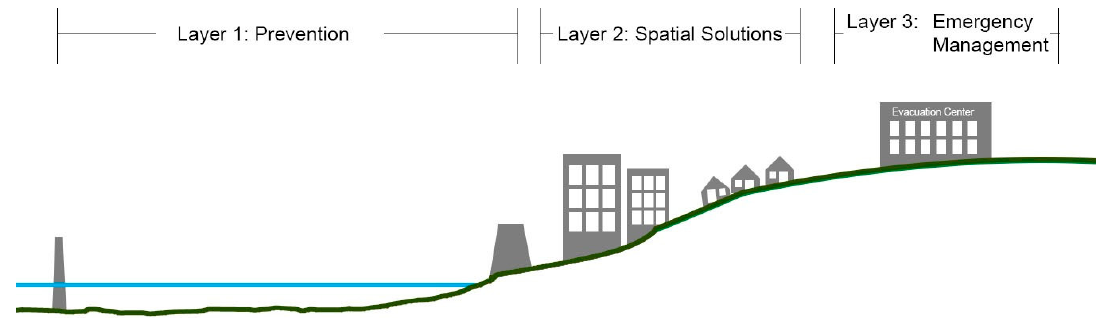
Figure 6. Multi-layer safety in a coastal flood protection system [32]. Reprinted from Exposing Underlying Risk: Disaster Risk Awareness in Informal Coastal Settlements with Low Disaster Threats (Master’s Thesis). By V.P.B. Valenzuela, 2018, The University of Tokyo, Tokyo, Japan. Copyright 2018 by Ven Paolo Bruno Valenzuela. Reprinted with Permission.